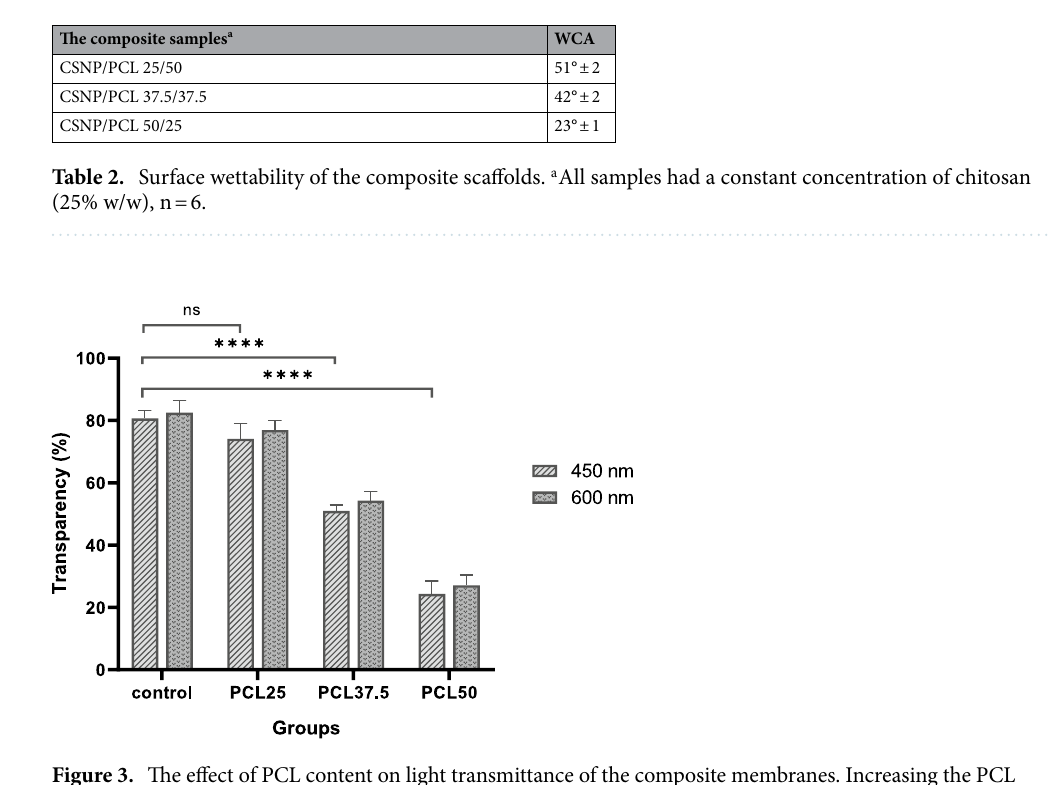
Figure 3. The effect of PCL content on light transmittance of the composite membranes. Increasing the PCL ratio in the composite led to increase the membrane opaque. All investigations were done triplicate (n = 3) under wet condition. Data was represented as mean ± SD (**** P <